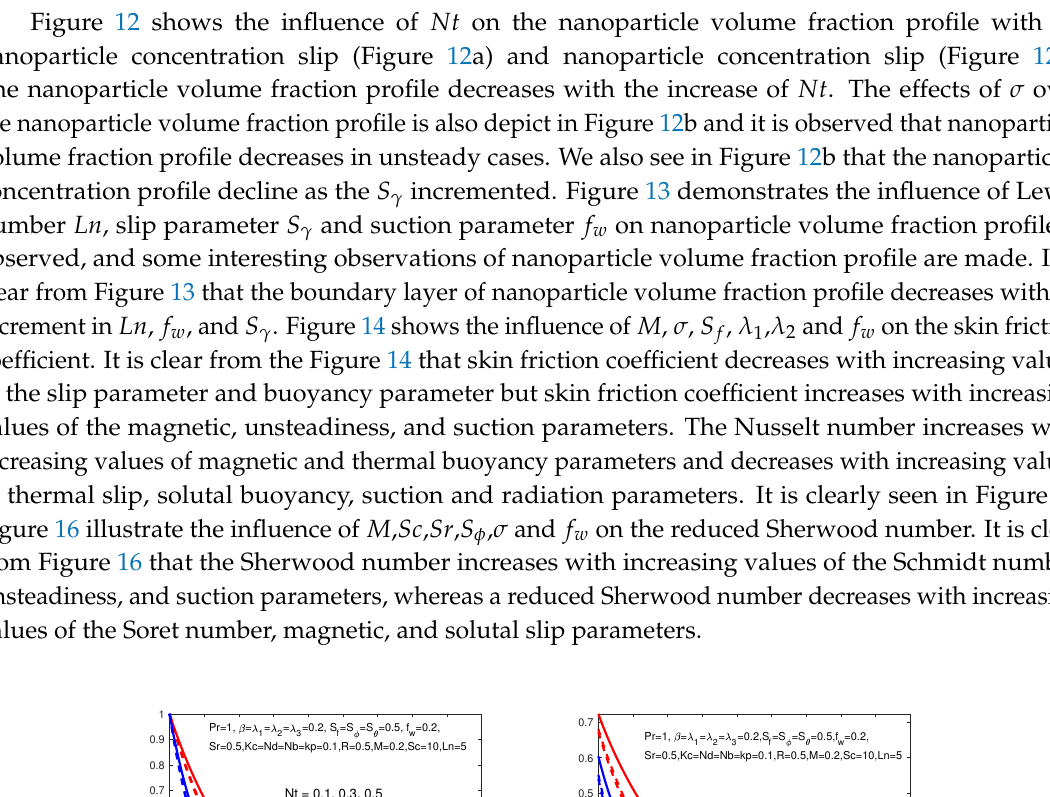
Figure 11. Influence of Sr and σ on φ . ( a ) No solutal slip. ( b ) With solutal slip.